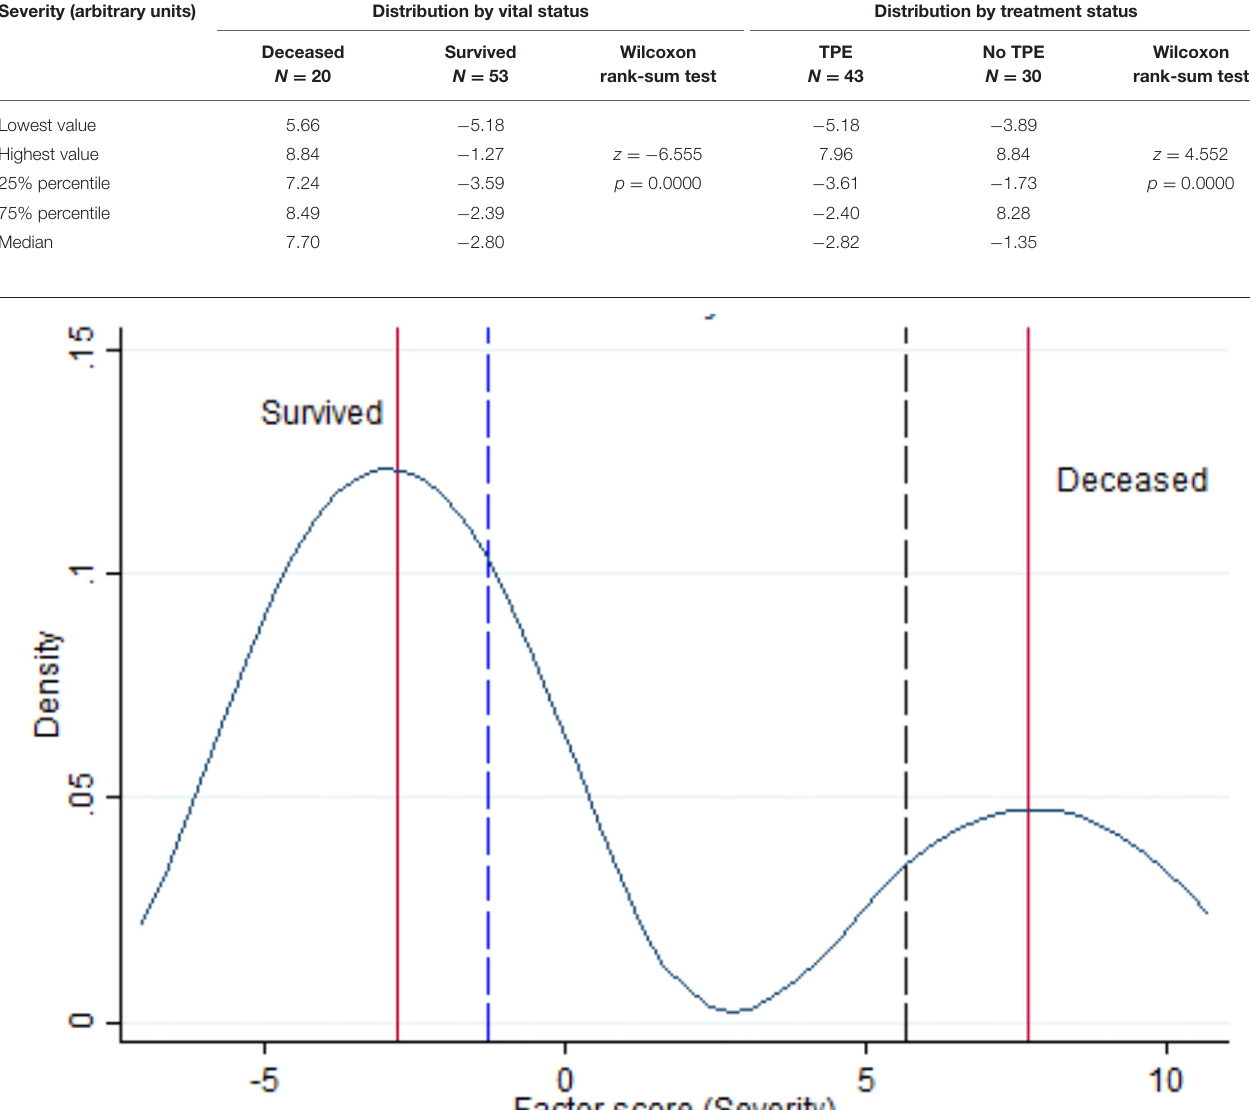
TABLE 2 | Distribution of the latent variable Severity in 73 patients with COVID-19 by vital status at end of follow-up and by treatment with therapeutic plasma exchange (TPE).